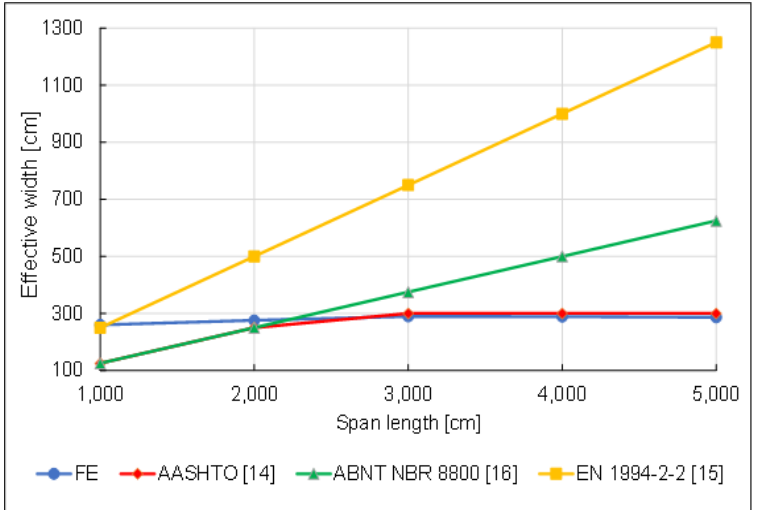
Figure 14. Effective width versus span length for single box